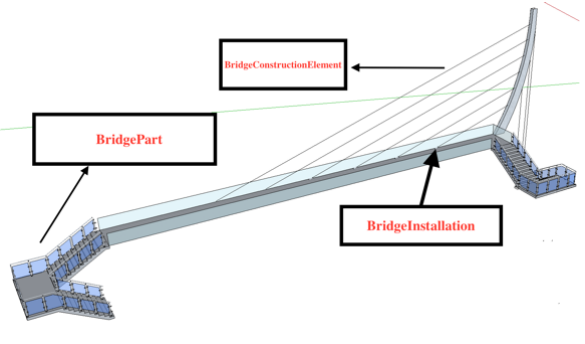
Figure 3: Bridge model